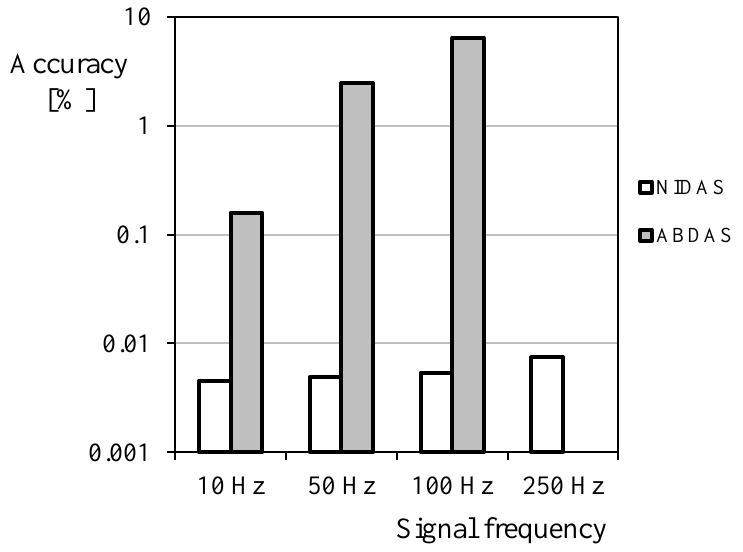
Figure 14. Estimated accuracy ABDAS and NIDAS in relation to the frequency of the signal measured (Equation (3)).